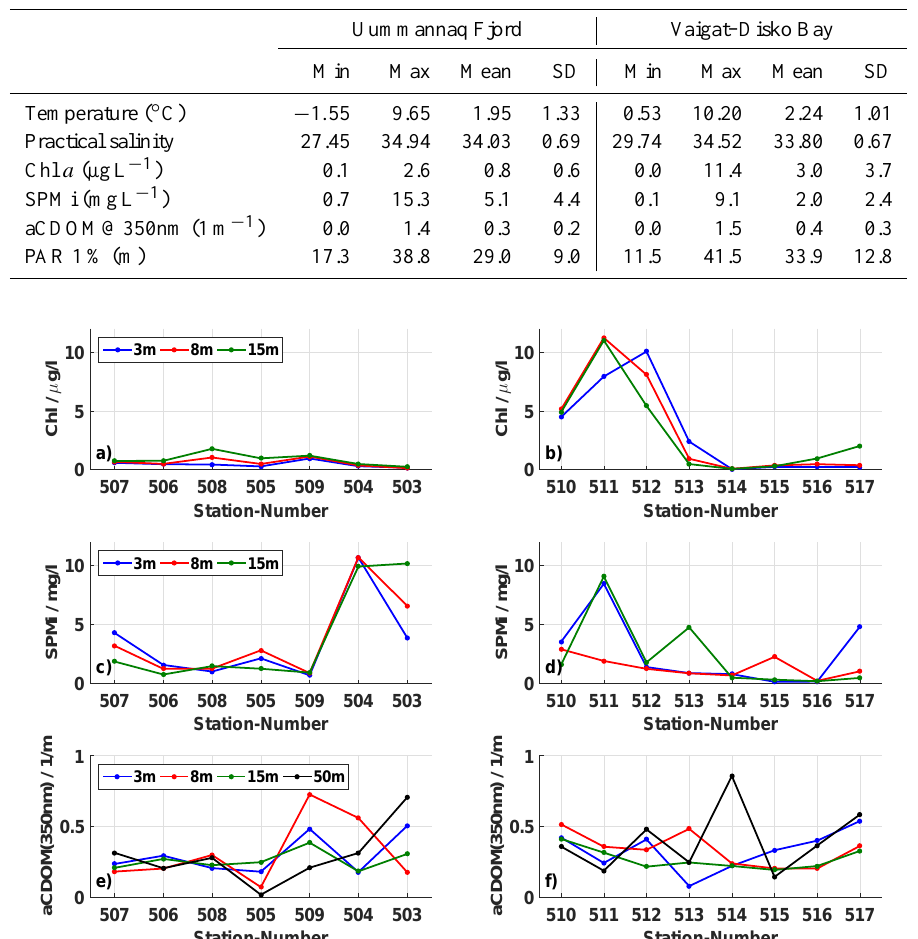
Figure 4. Comparisons of laboratory Chl a concentrations at 3m (blue), 8m (red), and 15m (green) are presented in (a) (Uummannaq Fjord) and (b) (Vaigat–Disko Bay). Highest concentrations were observed in the Vaigat (510–513). Graphs (c) and (d) show laboratory-sampled SPMi concentrations at the same three depths. CDOM (350nm) absorption is displayed in (e) and (f) at the depths mentioned before and in addition at